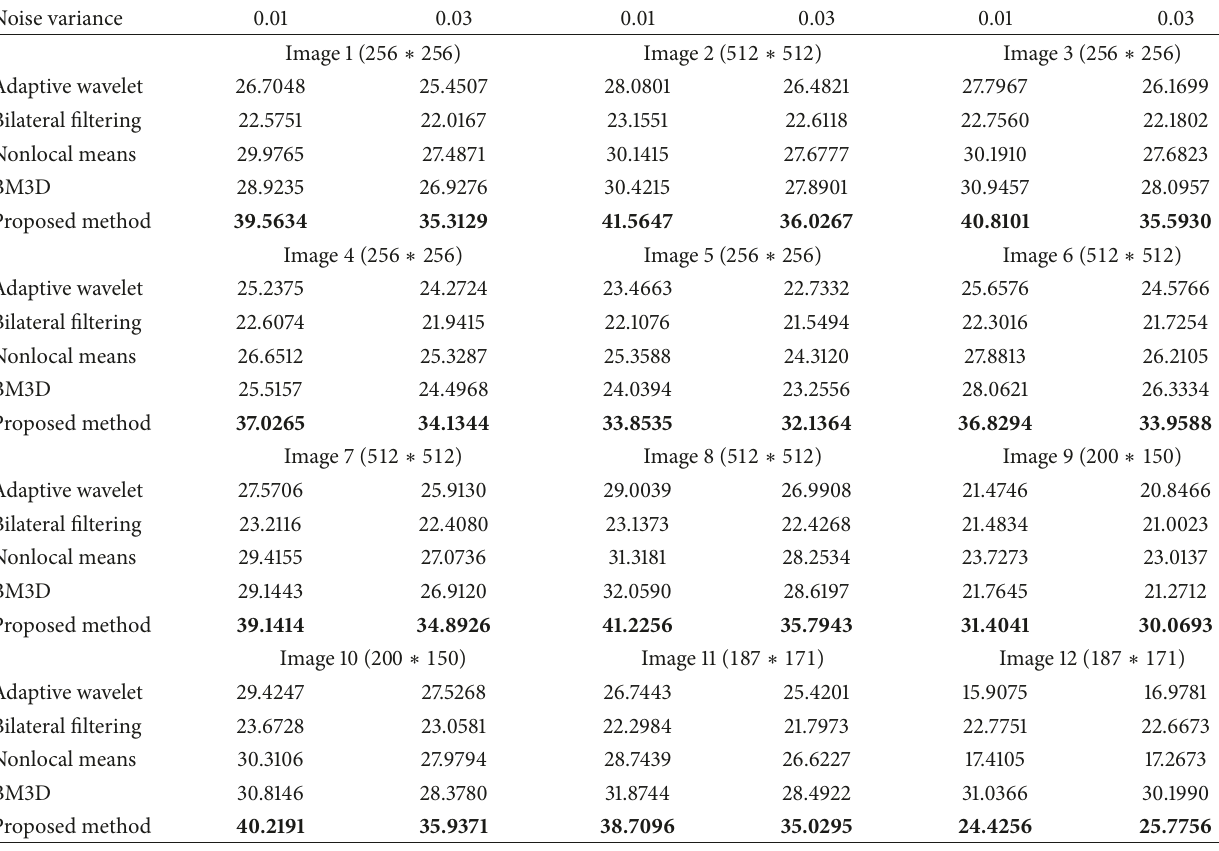
Table 1: PSNR of the proposed method, bilateral filtering, and adaptive wavelet.